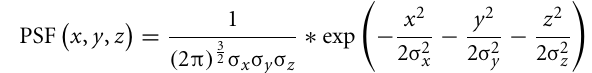
Frontiers in Neural